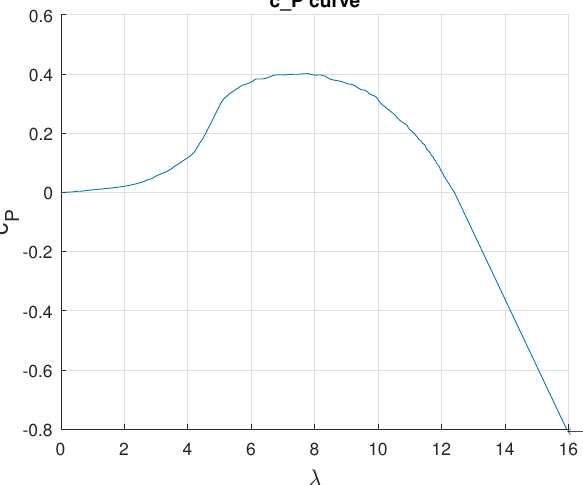
Figure 1. c P - λ curve of the MOWEA (Modulare Windenergieanlagen GmbH) wind